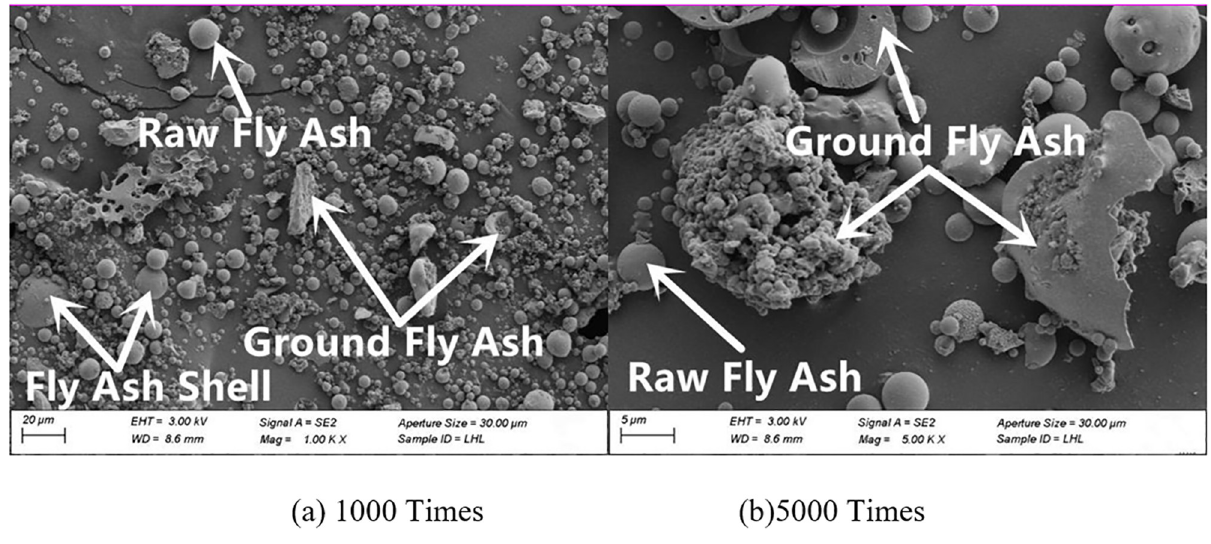
Fig 10. Fly ash microstructure in grinding for 60 min.